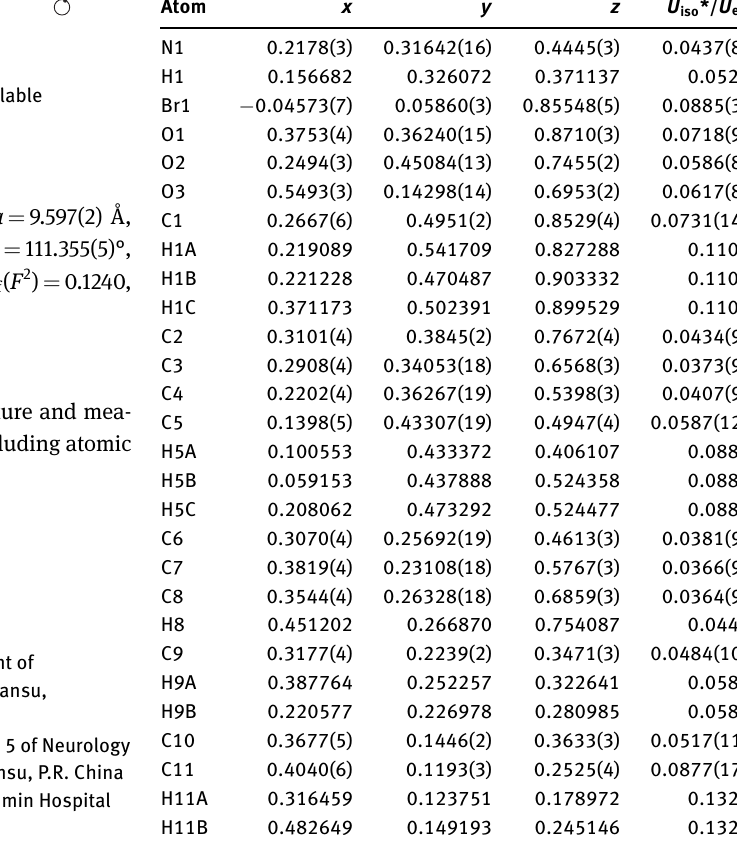
Table 2: Fractional atomic coordinates and isotropic or equivalent isotropic displacement parameters (Å 2